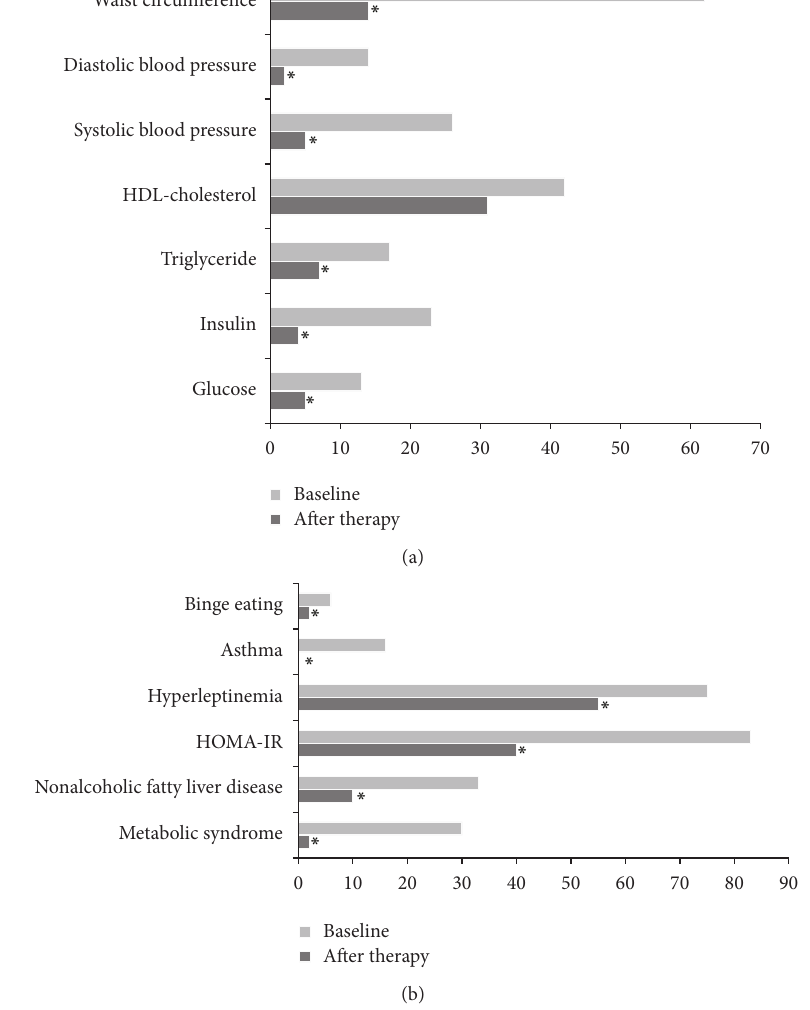
Figure 3: Prevalence of obesity complications: (a) metabolic syndrome factors; (b) comorbidities associated with obesity; ∗ statistical significance, 𝑃 < 0.05